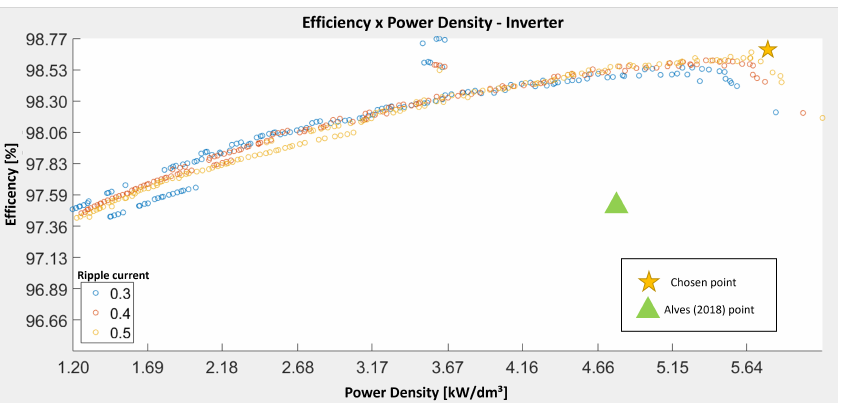
Figure 4. Pareto front ( ρ − η ) for the inverter.